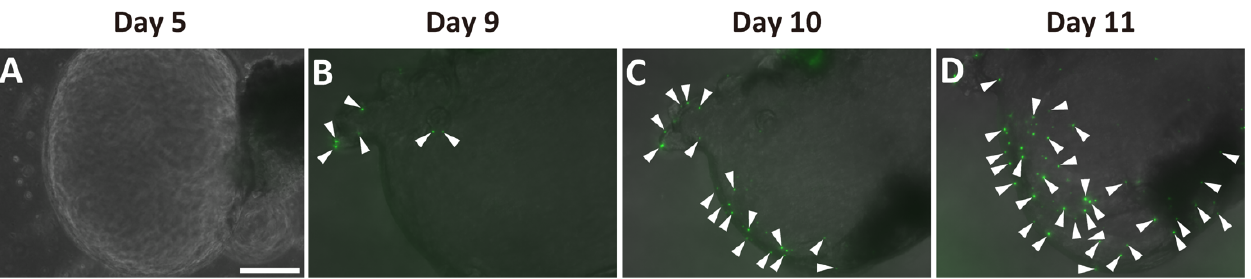
Figure 3. Emergence of Ngn3-GFP-positive cells in pancreatic ductal organoid. Ductal organoids were generated from Ngn3-GFP mice, and GFP expression, representing Ngn3 expression, was monitored. Ngn3-GFP expression was not observed on day 5 ( A ), but first appeared around days 7–9 of culture ( B ). GFP-positive cells started increasing thereafter ( B – D , arrowheads) (bar: 250 µm).